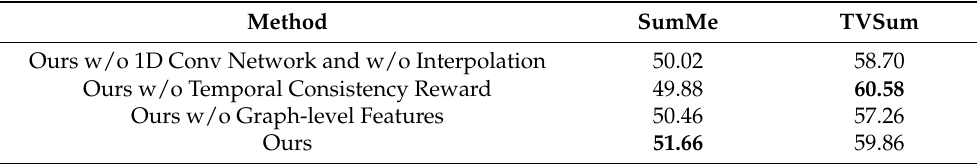
Table 2. Results (F-measure, %) of the comparison among variants with 15 kernel sizes and three stride sizes.